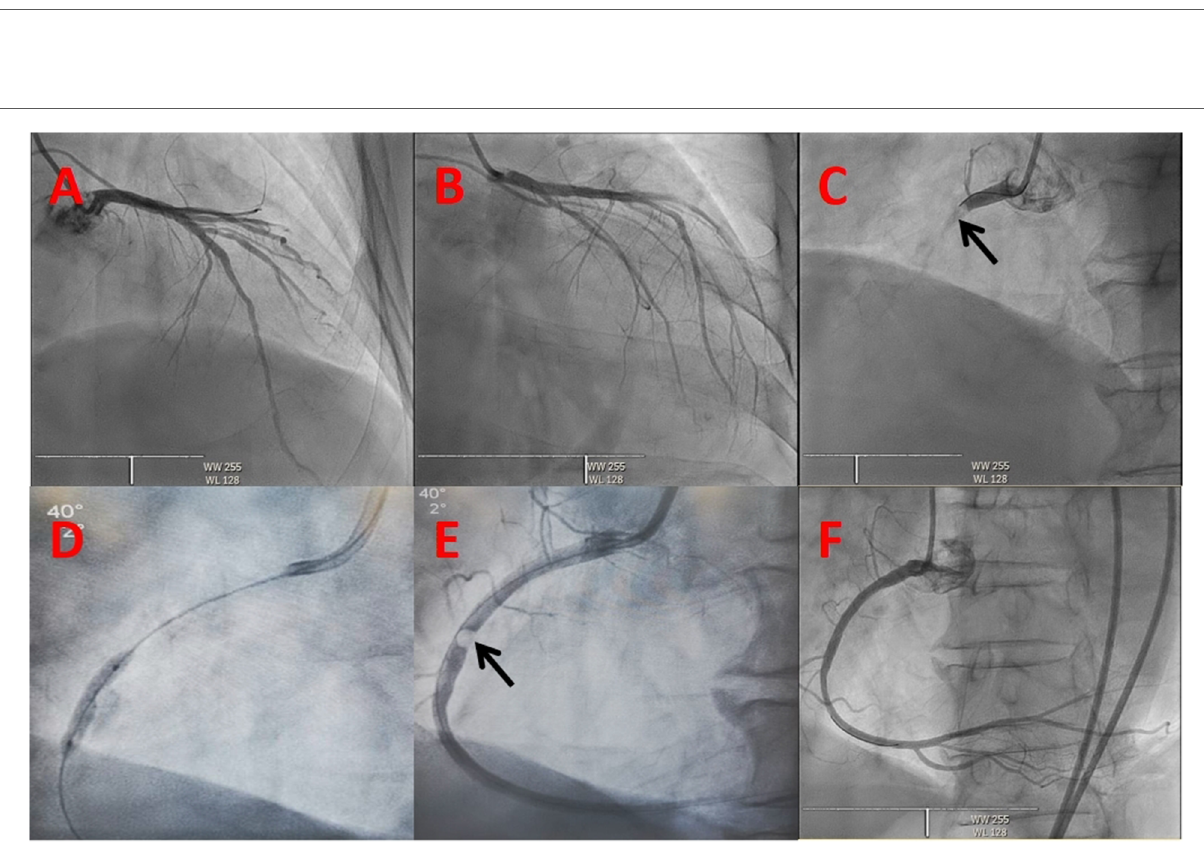
FIGURE 1 ECG in the ER before the coronary angiogram. ECG showing AF, complete heart block, junctional escape rhythm, and ST-segment elevation in leads II, III, aVF, and V3R-V5R.